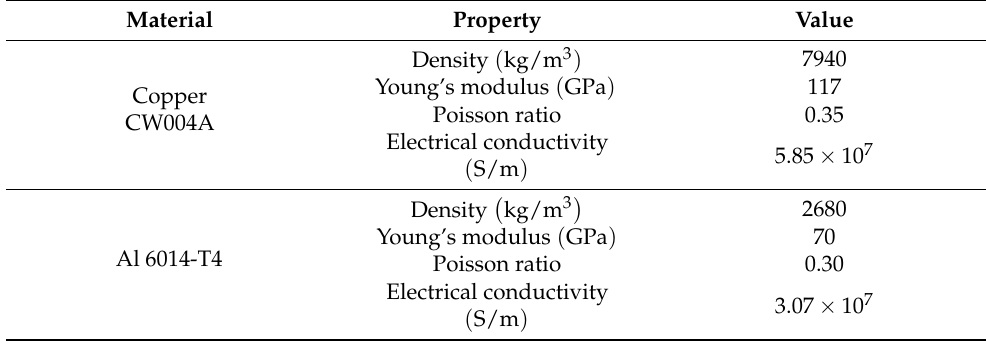
Table 2. Material properties of copper CW004A [12] and Al 6014-T4.